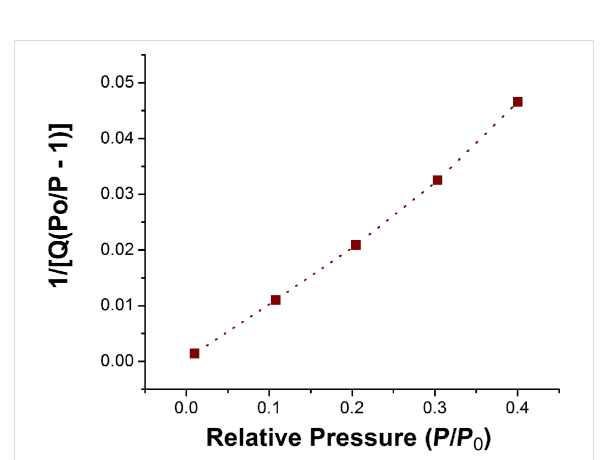
Figure 8: Calculation of band gap of Ta 2 O 5 nanoparticles by Tauc plot.